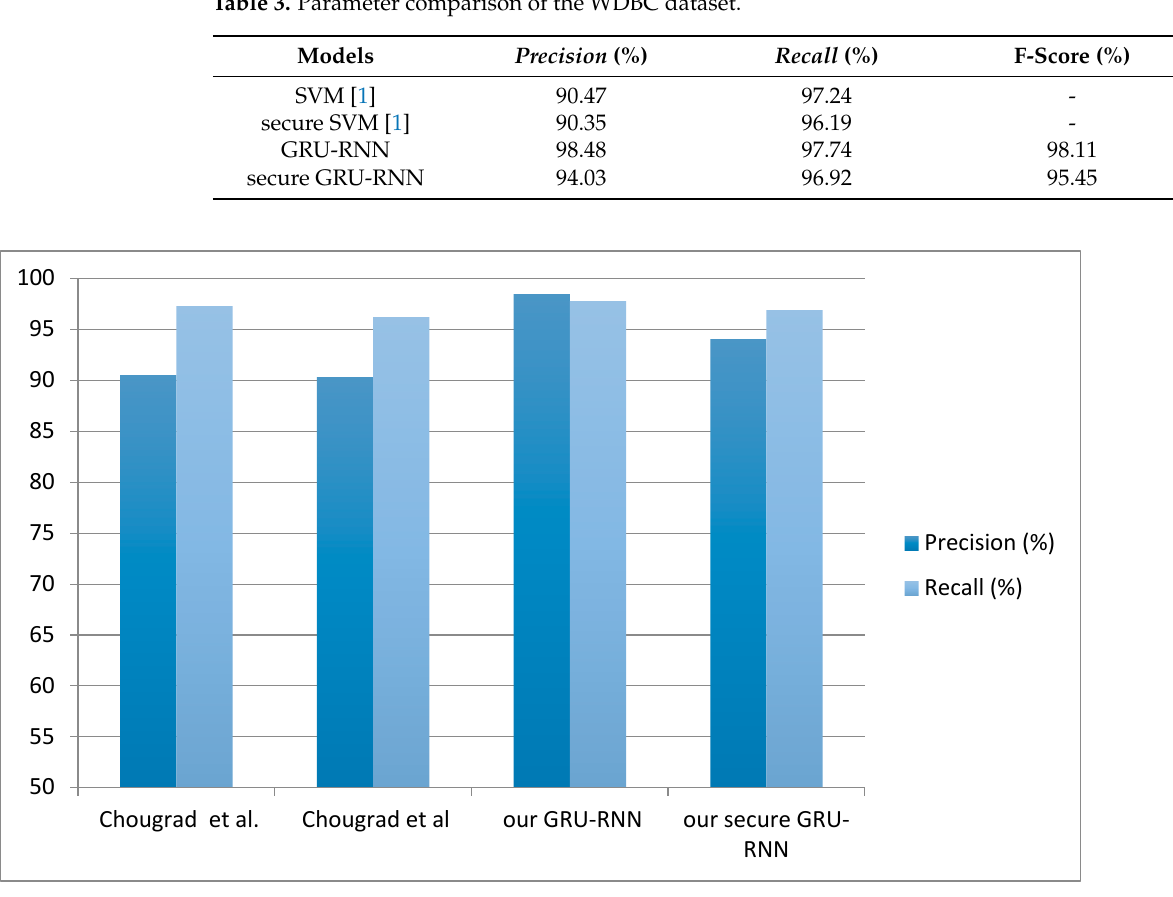
Figure 7. Performance comparison for the HDD dataset. The existing SVM and secure SVM had recalls of 97.24% and 96.19%, respectively. The GRU-RNN and secure GRU-RNN obtained recalls of 97.74% and 96.92%, respec- tively. It was observed that there was an improvement of 0.5% without secure training